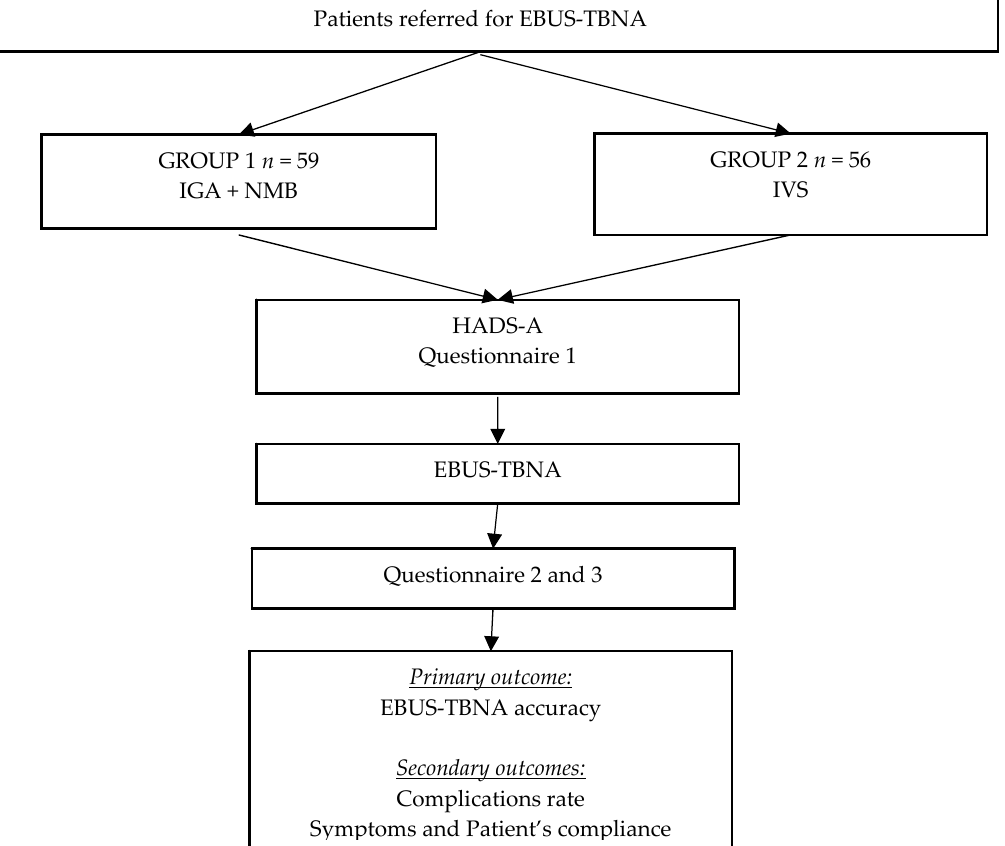
Figure 1. Study protocol. IGA, intravenous general anesthesia; NMB, neuromuscular blockade; IVS, intravenous sedation; EBUS-TBNA, endobronchial ultrasound-guided needle aspiration; HADS-A, Hospital Anxiety and Depression Scale.